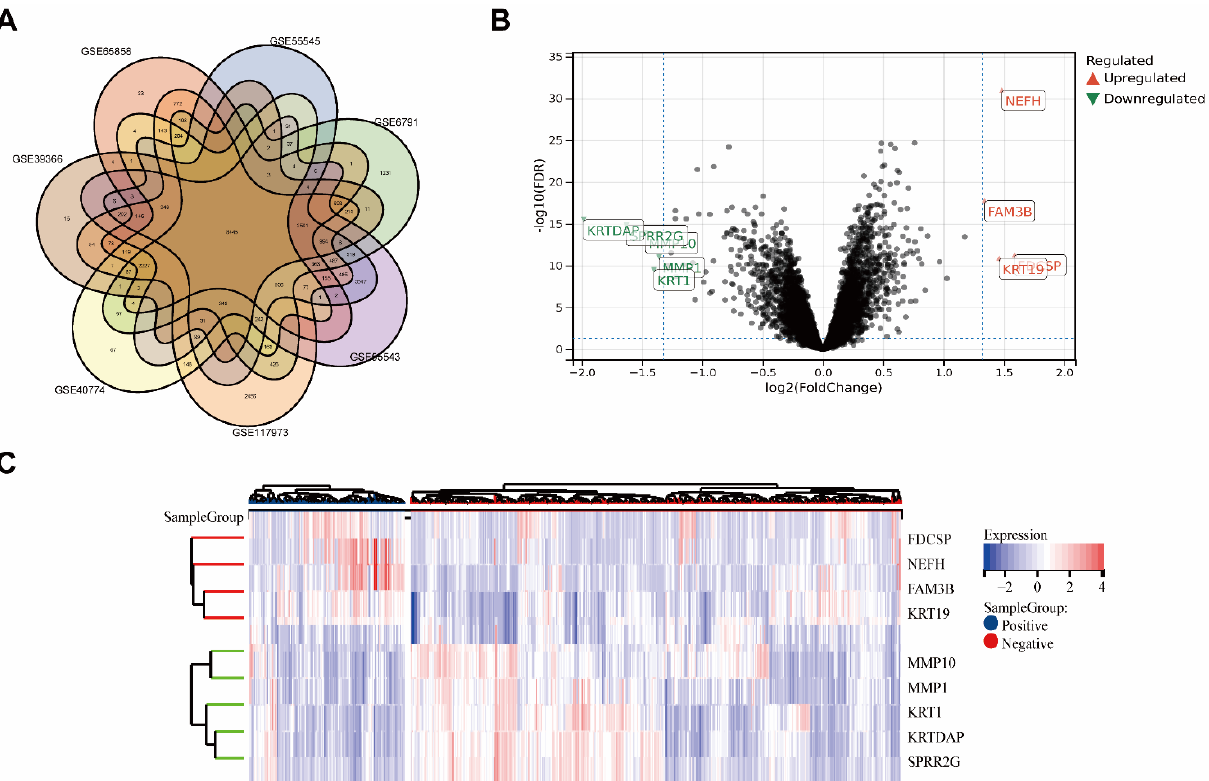
Figure 1. Screening of HPV-related differential genes using the GEO database. ( A ) Venn diagram for GEO datasets. ( B ) Volcano map of differentially expressed genes in HPV+ verse HPV − group. (FDR < 0.05, fold change = 2). ( C ) Heatmap of differentially expressed genes, clustered by HPV status.